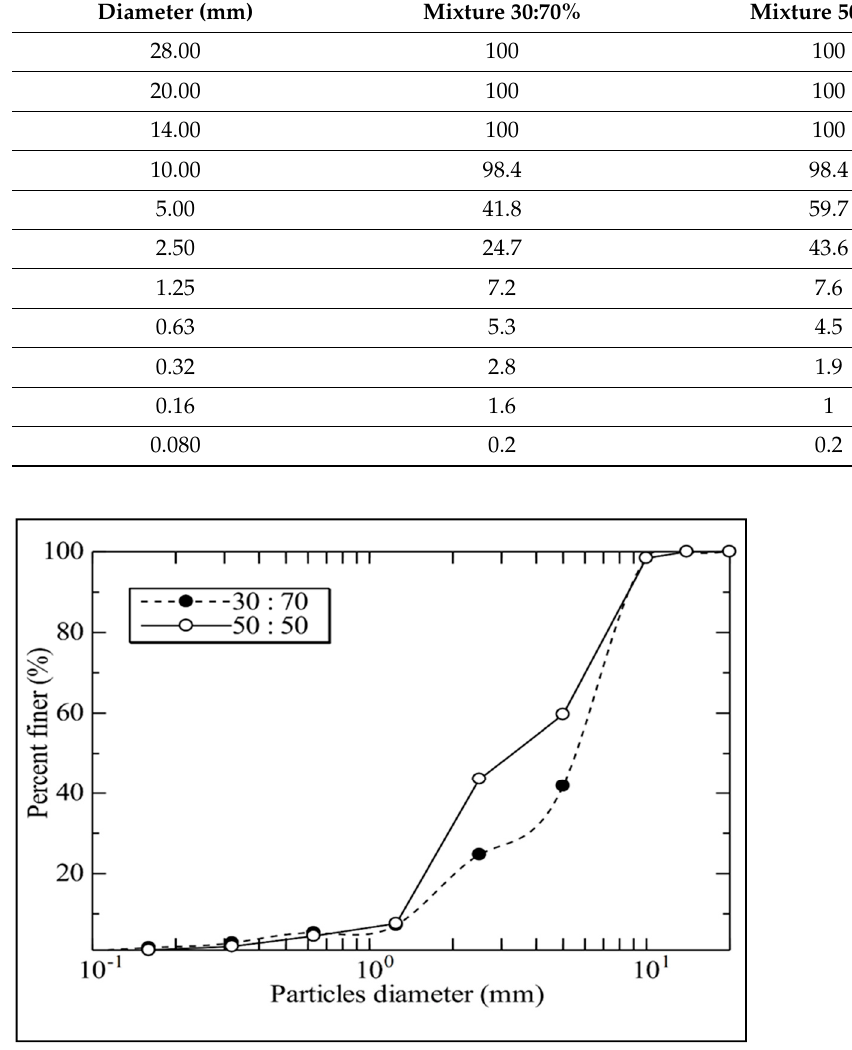
Figure 2. Gradation curves for two mixtures of sand (30:70% and 50:50%). Table 3. Chemical composition of OPC and FA.